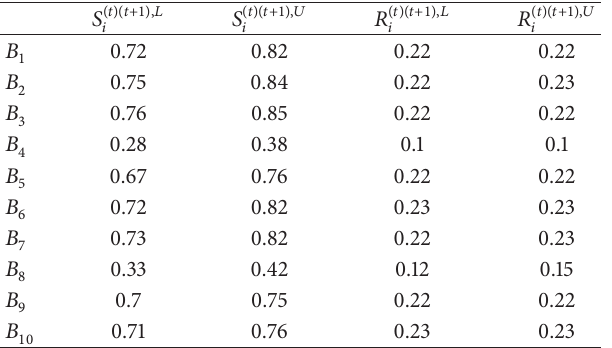
Table 17: 𝑄 interval numbers.